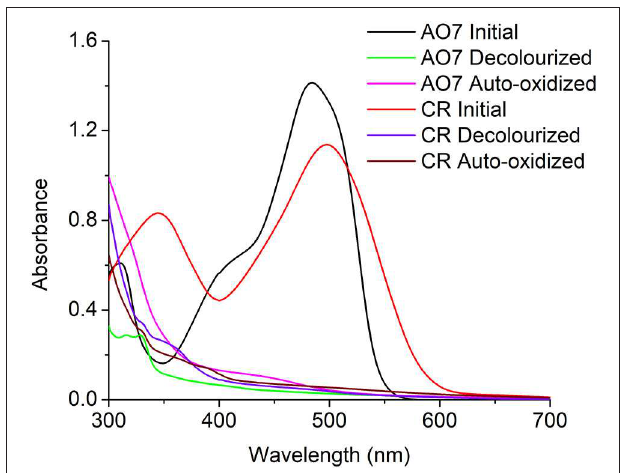
FIGURE 6 | UV-Scan of AO7 and CR initial dye, decolourized products, and Auto-oxidation products indicating the color in the auto-oxidation products was not a result of